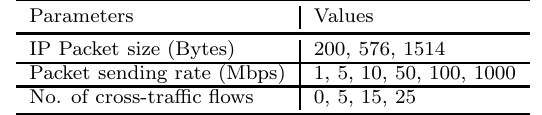
Table 1: Parameters tested in the packet-train